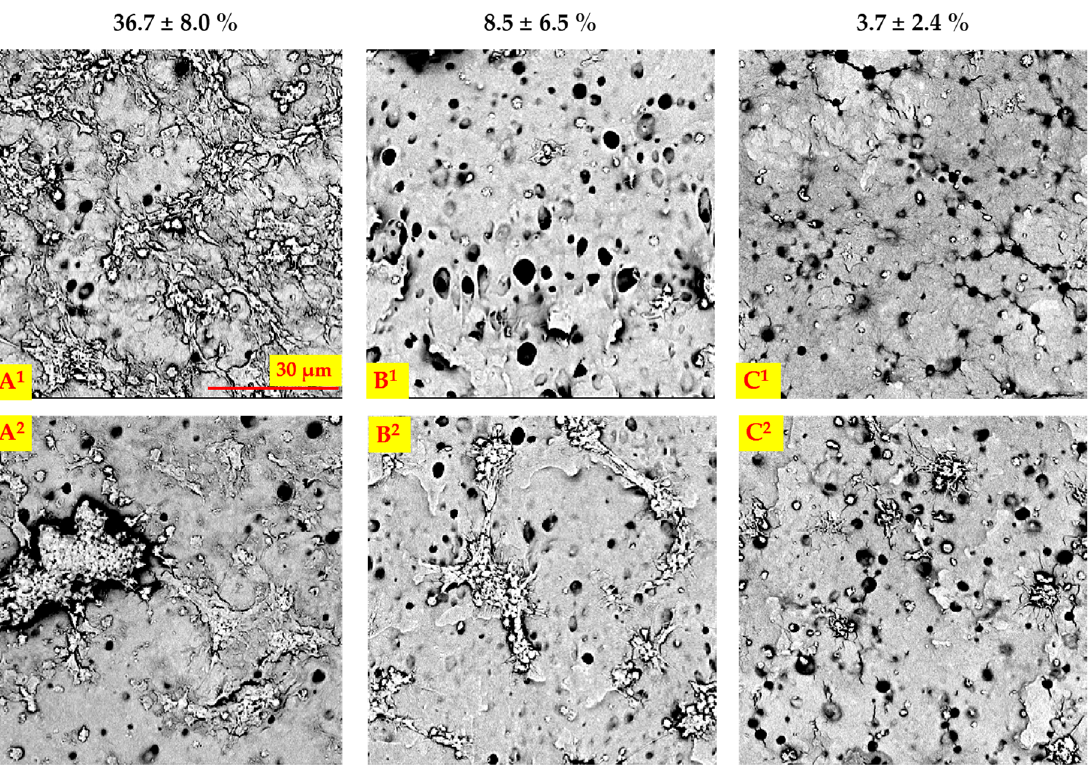
Figure 9. SEM images of analyzed materials’ surface after contact with blood, ( A 1,2 ): unmodified PU, ( B 1,2 ): PU_REDV, ( C 1,2 ): PU_YIGSR, scale bar 30 μm; the percentage of the platelet-coated area is given above each image.